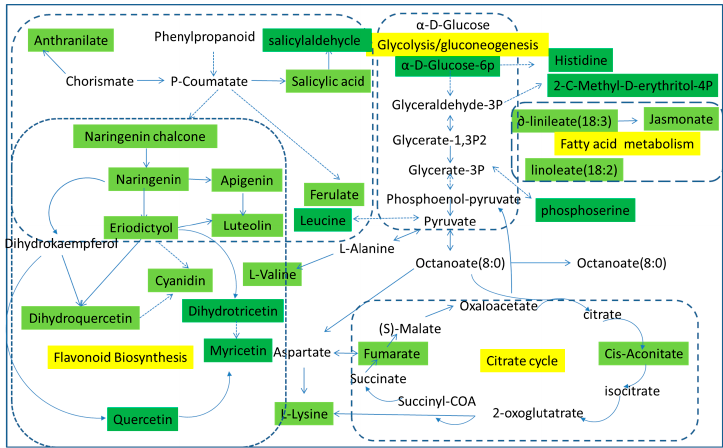
Figure 4. Metabolomic Pathway Analysis (MetPA) construction of the metabolic pathways involved in the etiolation of fresh-cut CWC.